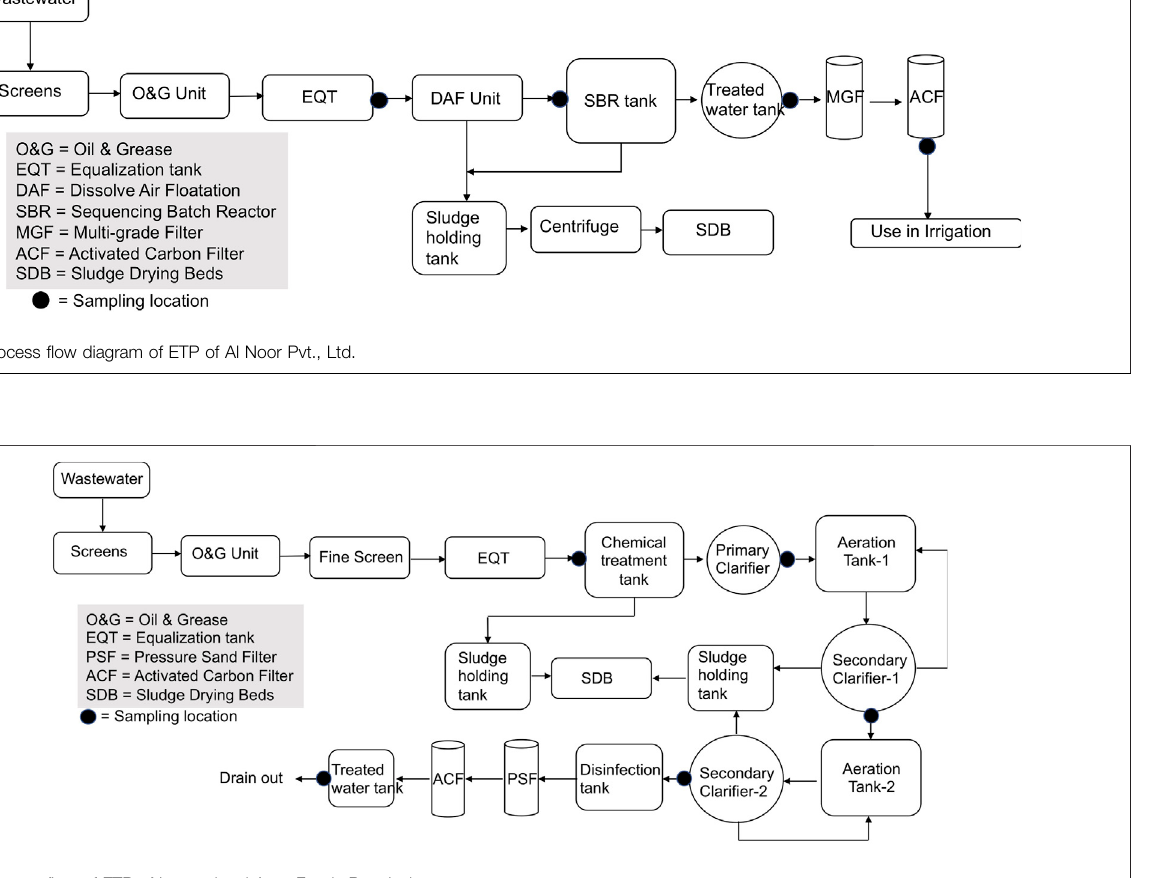
FIGURE 3 | Process fl ow of ETP of International Agro Foods Pvt.,